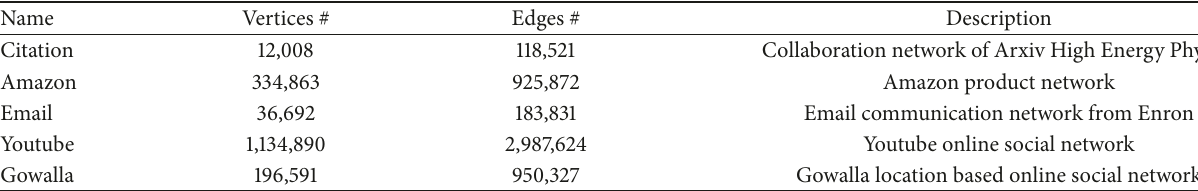
Table 2: Network statistics.